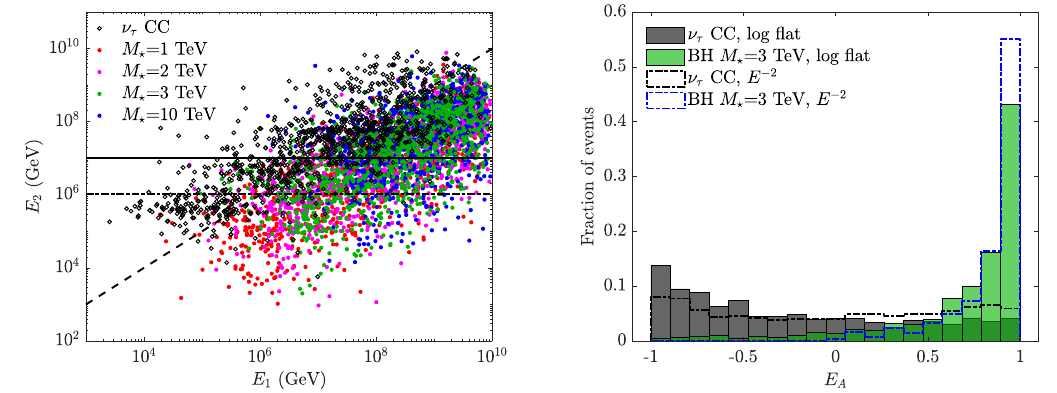
Figure 6 . Left: the energy of the (cid:12)rst cascade versus the energy of the second cascade in black hole simulations (colored dots) and (cid:23) (cid:28) charged current events (black circles). Red, magenta, green and blue dots correspond to simulations in 6 extra dimensions with M ? =1 TeV, 2 TeV, 3 TeV, and 10 TeV, respectively. The dashed line depicts the E 1 = E 2 threshold, the solid line shows the region above which most of the taus leave the detector, and the dash-dotted line shows the region below which most of the taus are supposed to decay within 100 m. Events in between would appear as \double bang-like." In each case, 1000 double bang-like events are simulated in the same way as (cid:12)gure 5. We require E (cid:28) > 1 TeV to produce a clear second cascade. Tau energy loss is not included. Right: histogram of the energy asymmetry factor E A in (cid:23) (cid:28) CC (shaded black) and M ? = 3 TeV black hole evaporation (shaded green) for a log (cid:13)at neutrino spectrum with in(cid:12)nite detector volume. Dashed lines show the corresponding cases using E (cid:0) 2 neutrino (cid:13)ux and a minimum energy deposition of 20 PeV. For these, in contrast with the shaded bars, only tau decays inside the detector are selected and the detector geometry is described in section 3.1. See section 5 for details. is peaked at large positive values for black hole events and (cid:23) CC is peaked at the negative (cid:28) end. The distinction is consistent with the discussion of double bang events in section